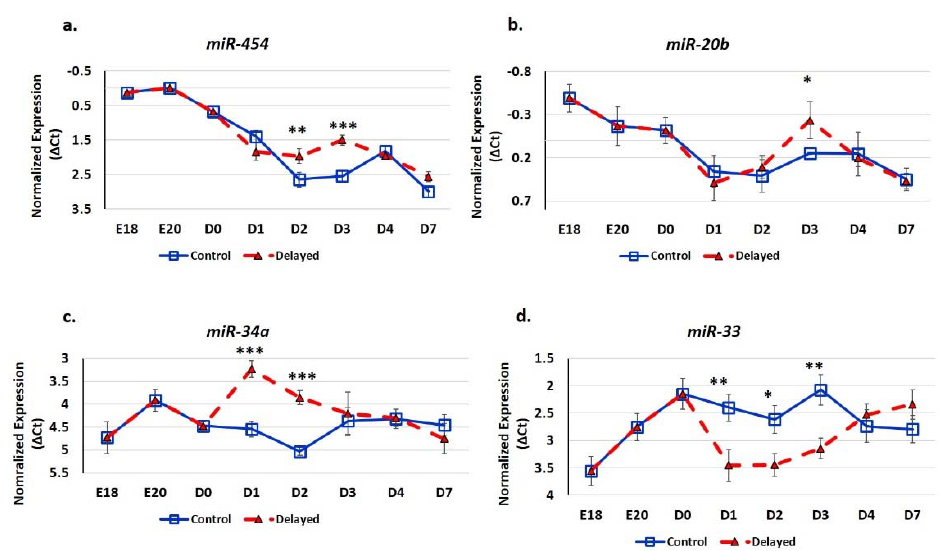
Figure 6. Delayed feeding of peri-hatch broiler chicks alters hepatic miRNA expression. ( a – d ) Real-time quantitative PCR (RT-qPCR) was utilized to measure the expression of hepatic miRNA expression. Values are shown as the mean ∆ Ct (n = 6 males) for each treatment group (fed at hatch or delayed) at each time point. MiRNA expression levels were normalized to snoU83B levels. Error bars denote standard deviations. Significant ( p < 0.05) di ff erences in expression were determined using analysis of variance. * p < 0.05, ** p < 0.01, *** p < 0.001 denote significant di ff erences between fed at hatch chicks and chicks with delayed access to feed for 48 h.